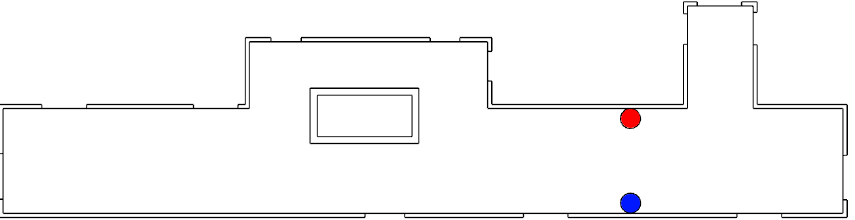
Figure 7. Three-dimensional model of the corridor from the floor plan in SketchUp.